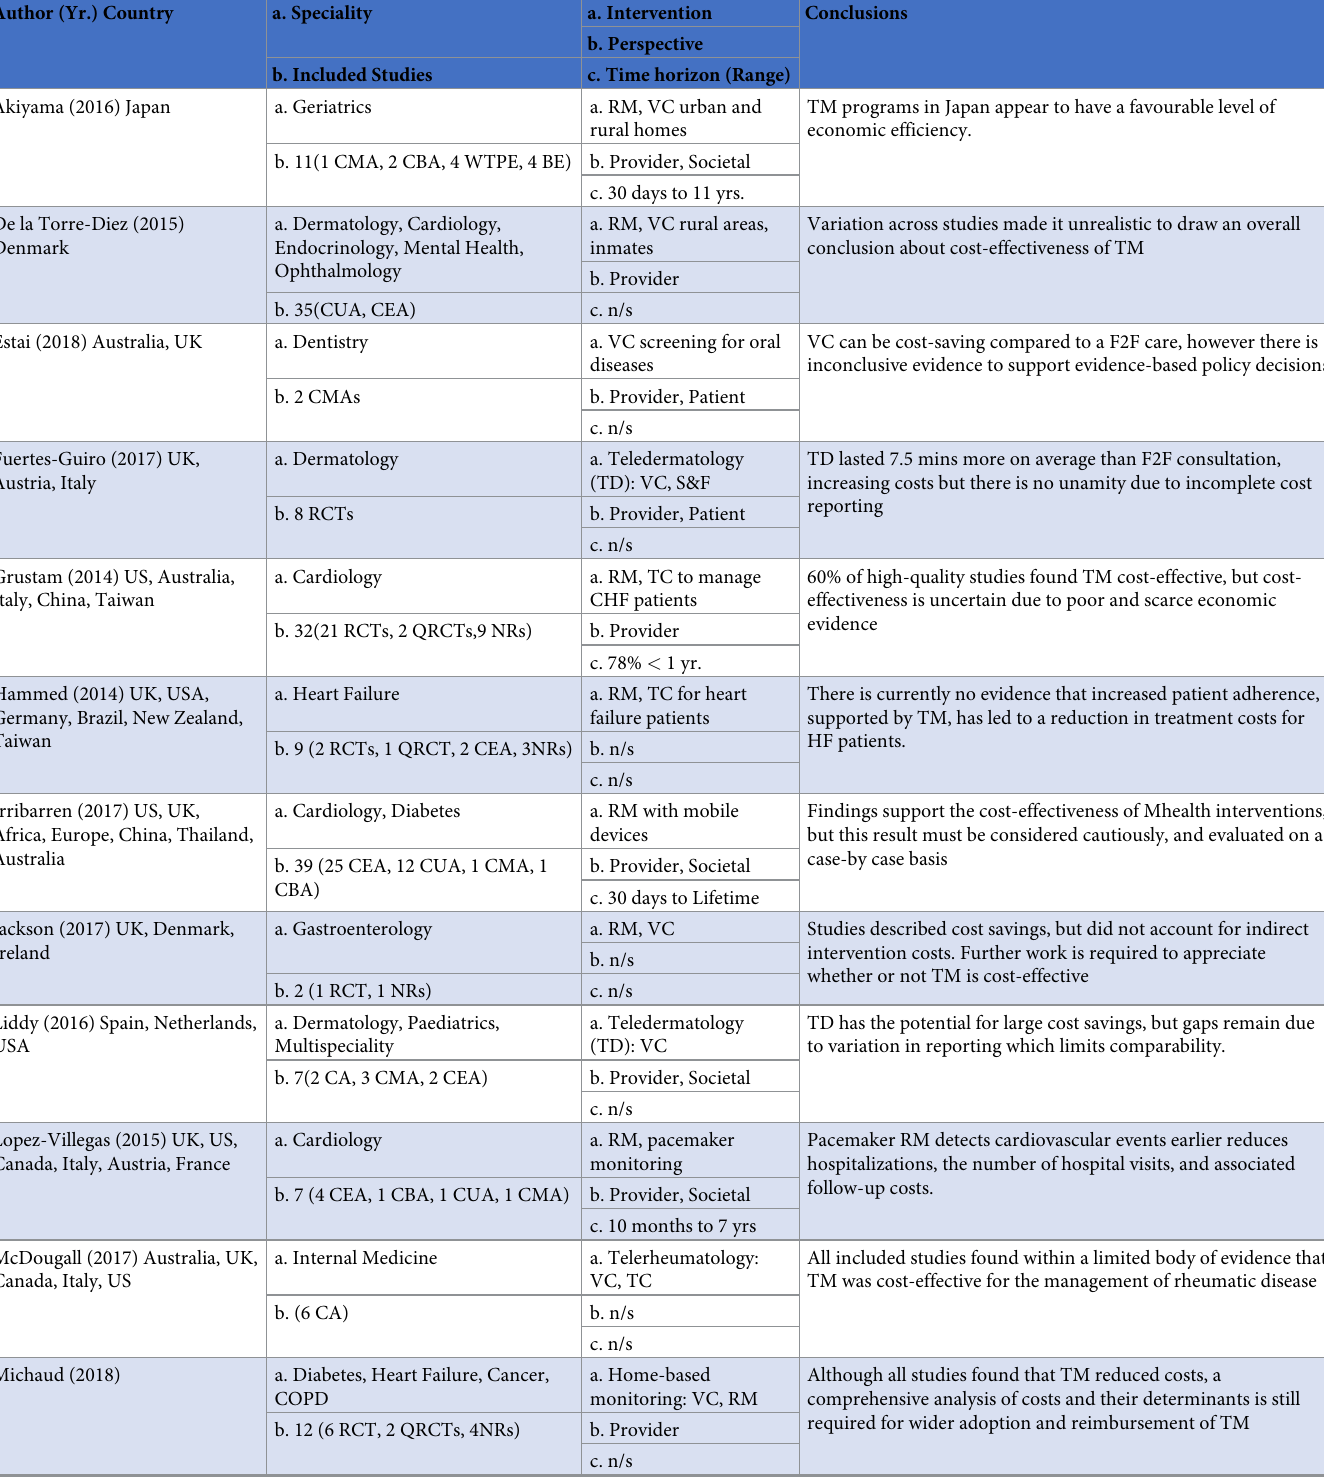
Table 3. Summary charactheristics of cost-effectiveness